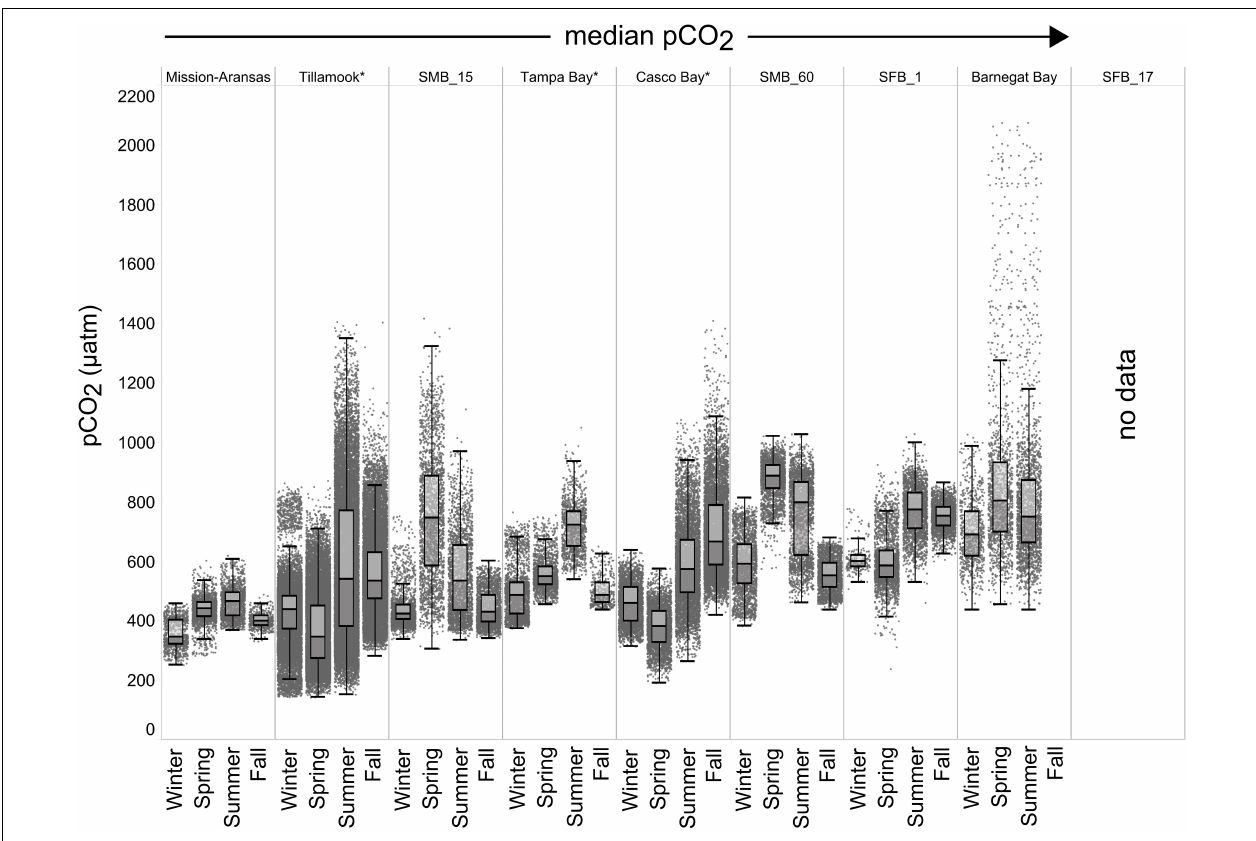
FIGURE 6 | Box plots and underlying data showing the seasonal distribution of partial pressure of carbon dioxide ( p CO 2 ), data across the seven water bodies. The water bodies are arranged from lowest median p CO 2 to highest median p CO 2 . Whiskers extend to data within 1.5 times the interquartile range (IQR).